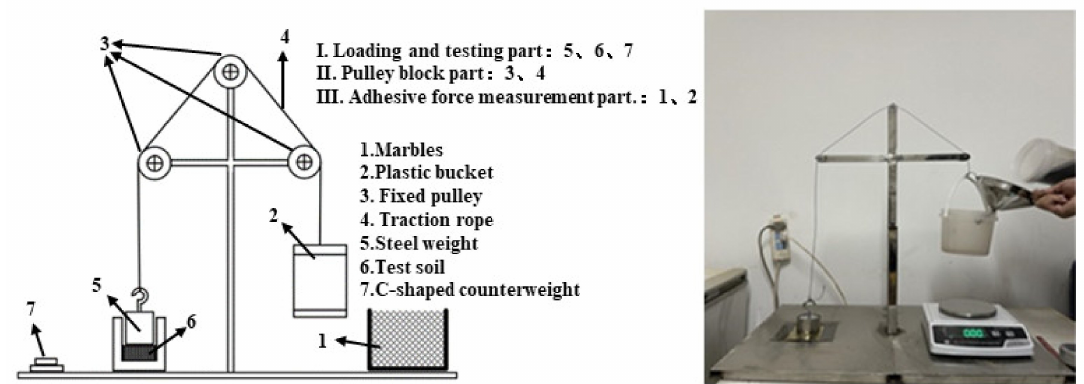
Figure 3. Diagram of device for adhesive force